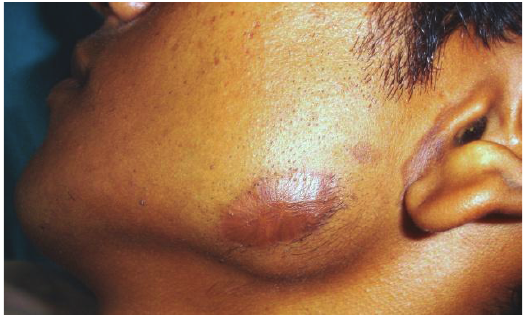
Figure 4: Pre-op left close-up view.